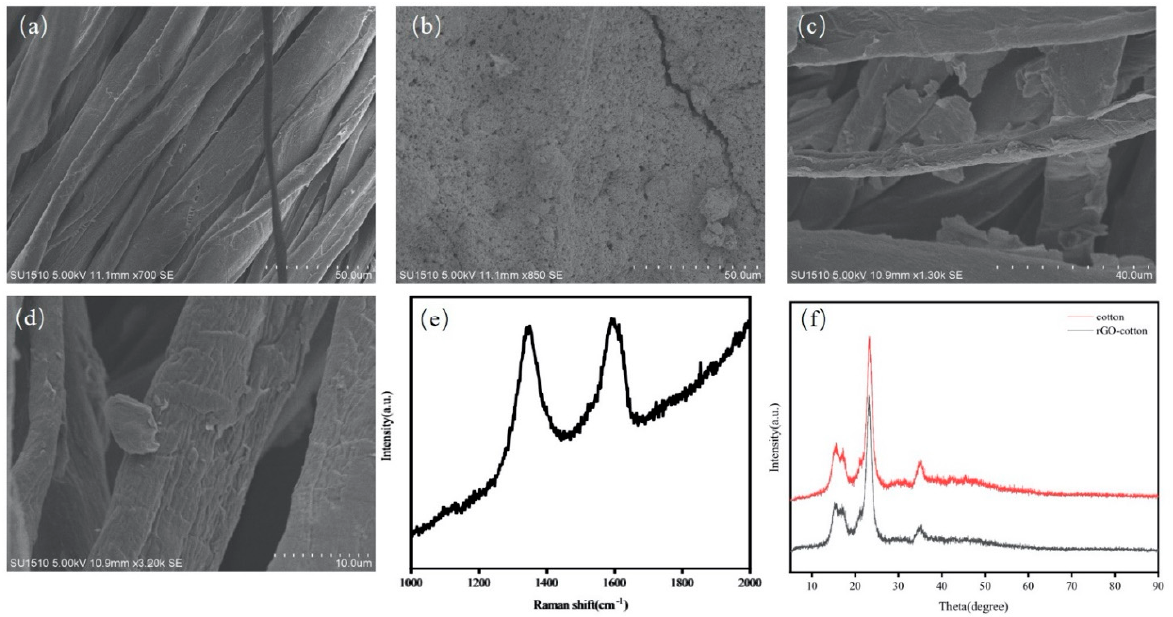
Figure 2. The scanning electron microscope (SEM) images of the surface morphology of ( a ) control cotton fabric, ( b ) the Ag fabric circuit electrode, and ( c , d ) the rGO-cotton electrode. ( e ) Raman spectrum of rGO-cotton. ( f ) X-ray diffraction (XRD) spectrum of cotton and rGO-cotton.